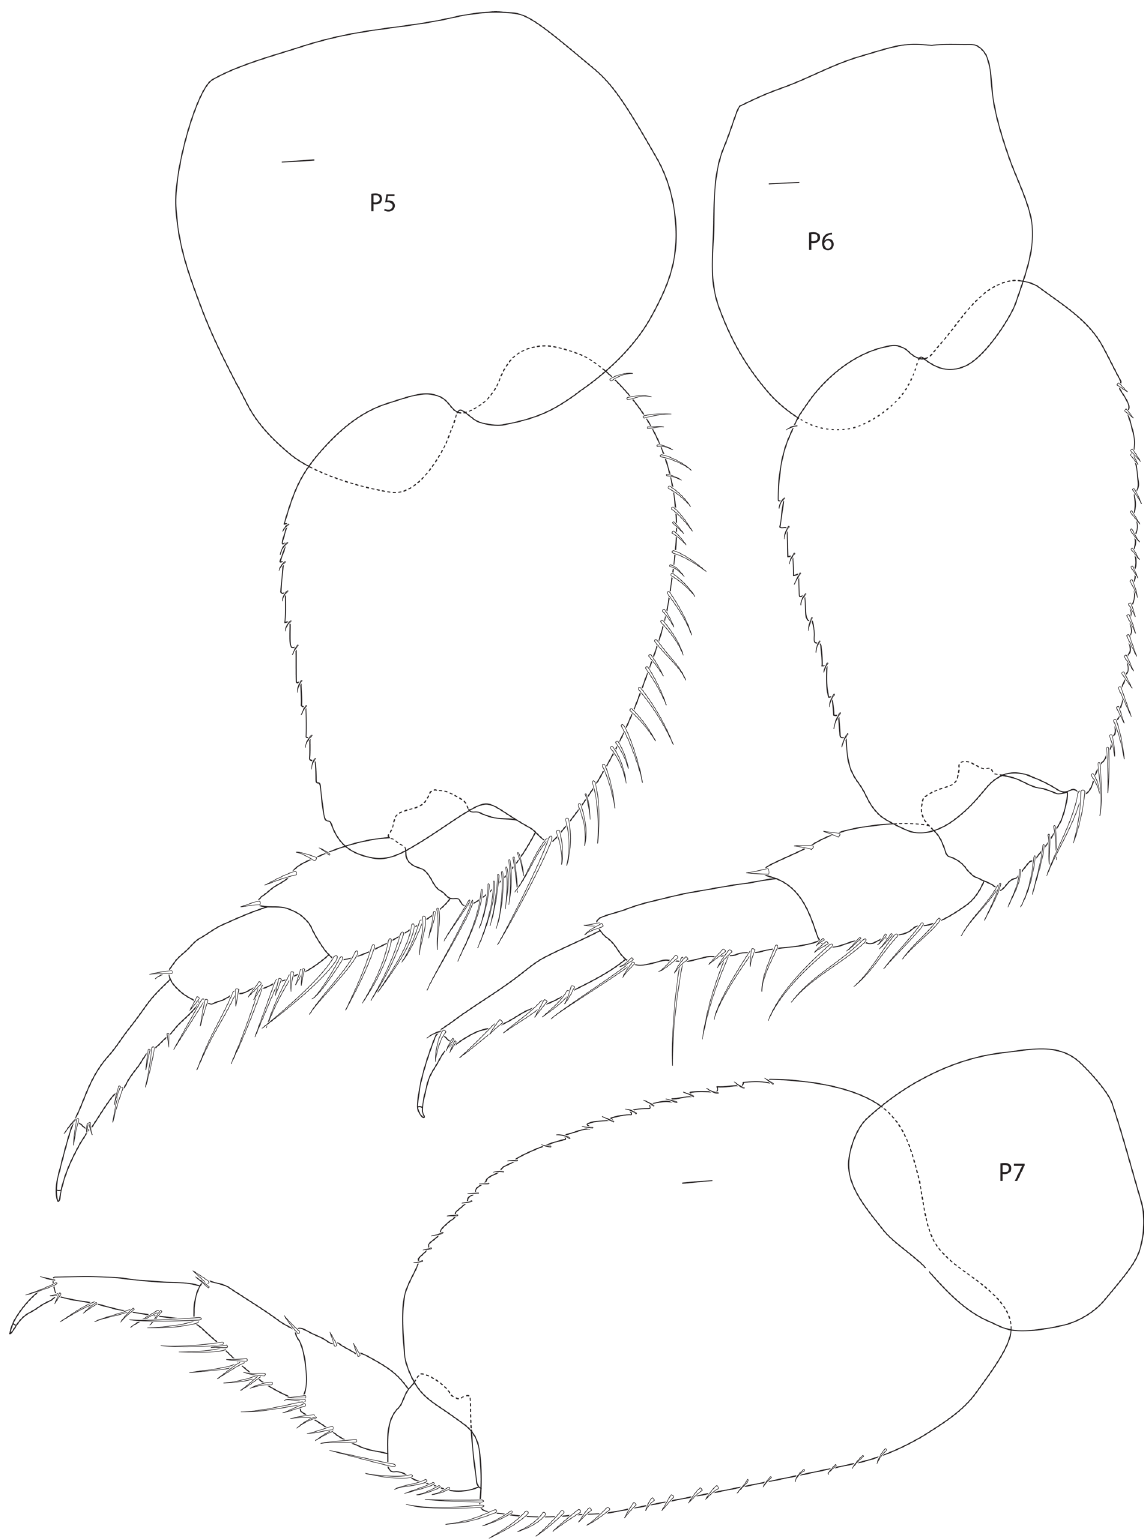
Fig. 10. Onisimus turgidus (Sars, 1879), ♀, 10 mm, Ullsfjorden (100 m depth) (TSZCr8573). Pereopods 5–7. Abbreviations: see Material and methods. Scale bars = 0.1